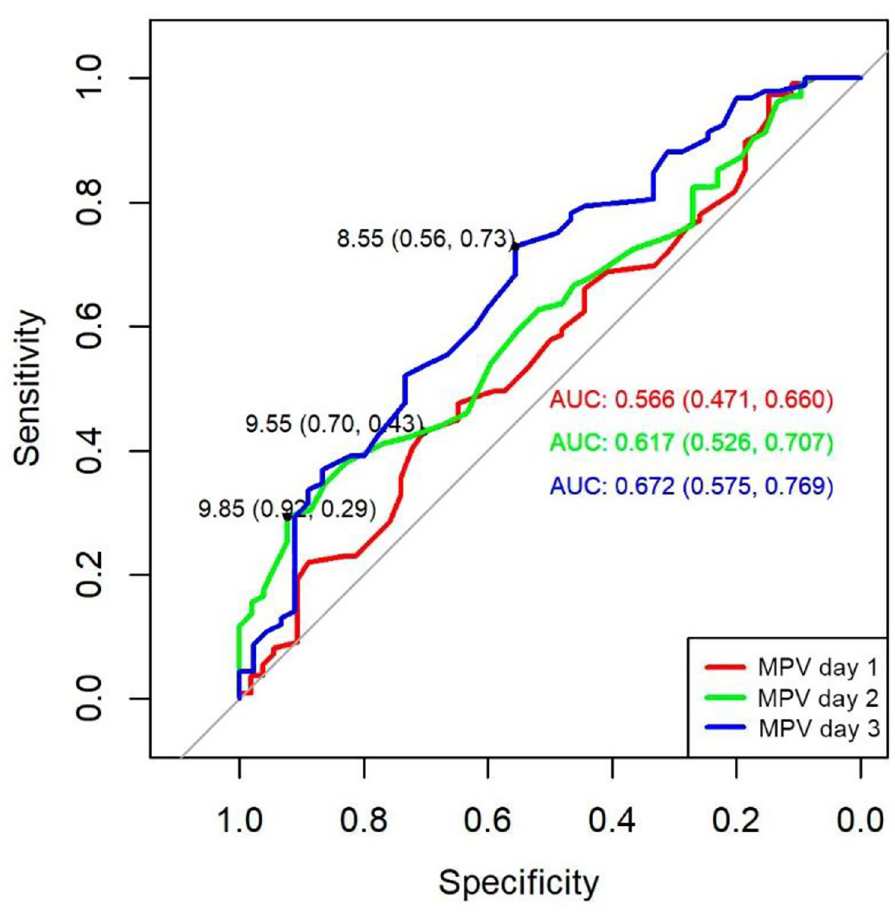
Fig 1. ROC curve of MPV to predict septic shock in septic patients. AUC: area under the curve.